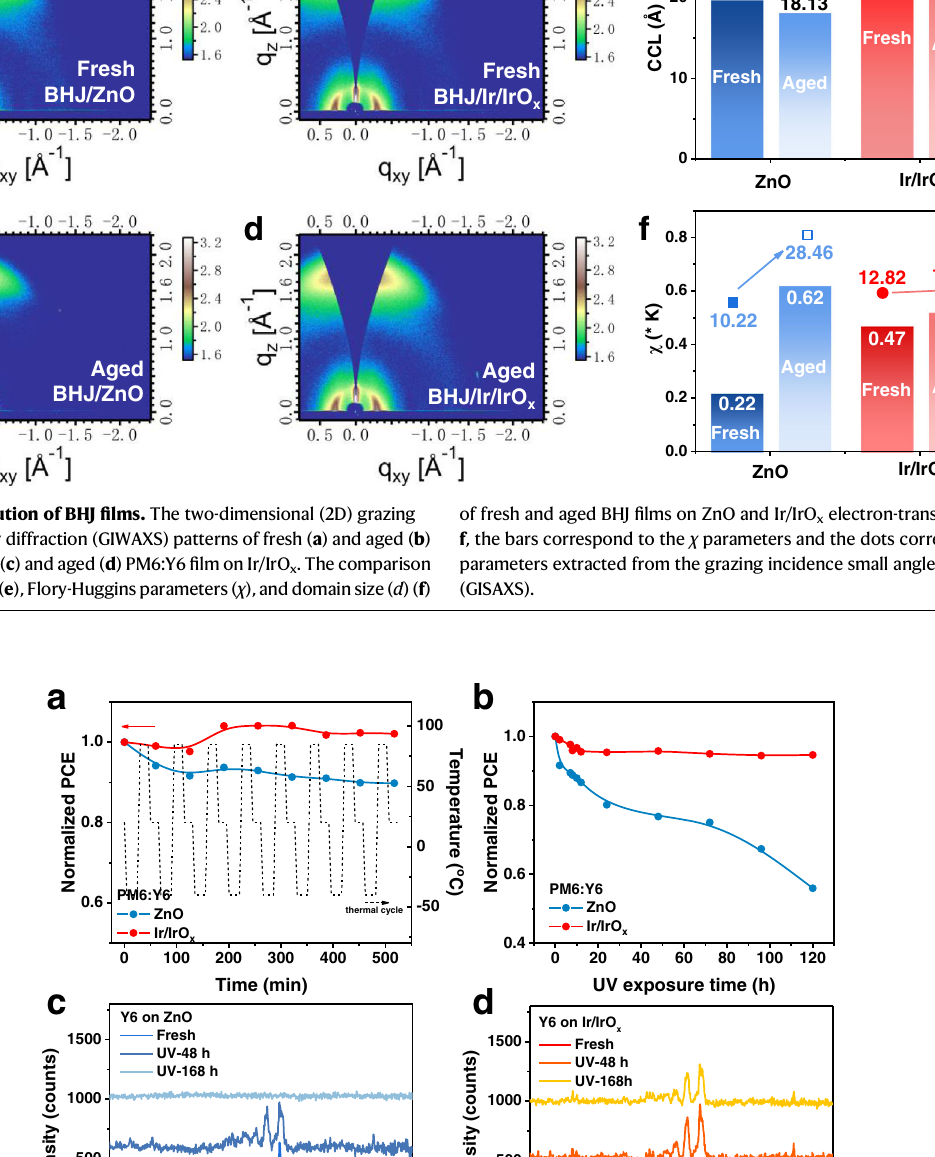
ultraviolet (UV)-irradiation time based on the champion PM6:Y6 devices with dif- ferent ETLs. The Raman spectra of Y6 fi lms on ZnO ( c ) and Ir/IrO x ( d ) during UV- irradiation aging.